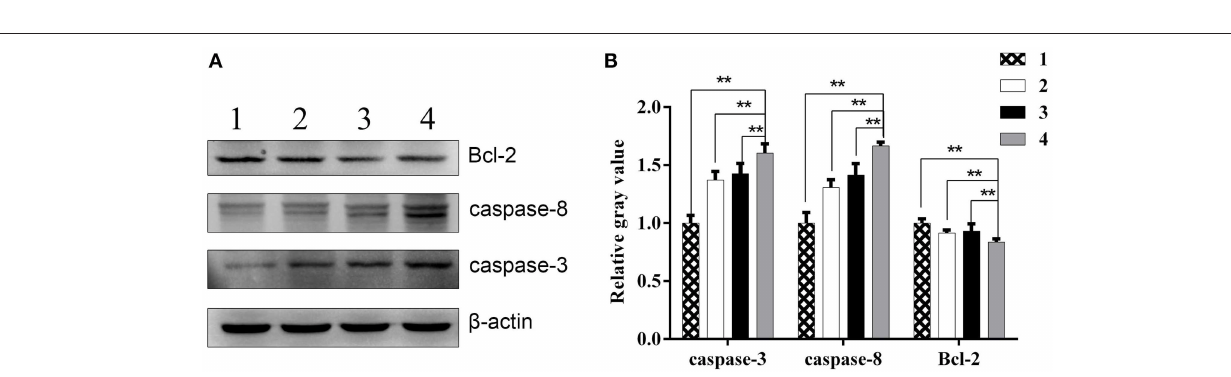
combination group, ZD55-IL-24 group, radiation group and PBS group was (21.59 ± 3.08), (41.14 ± 6.27), (60.48 ± 7.51), (74.43 ± 9.17), respectively. Compared with